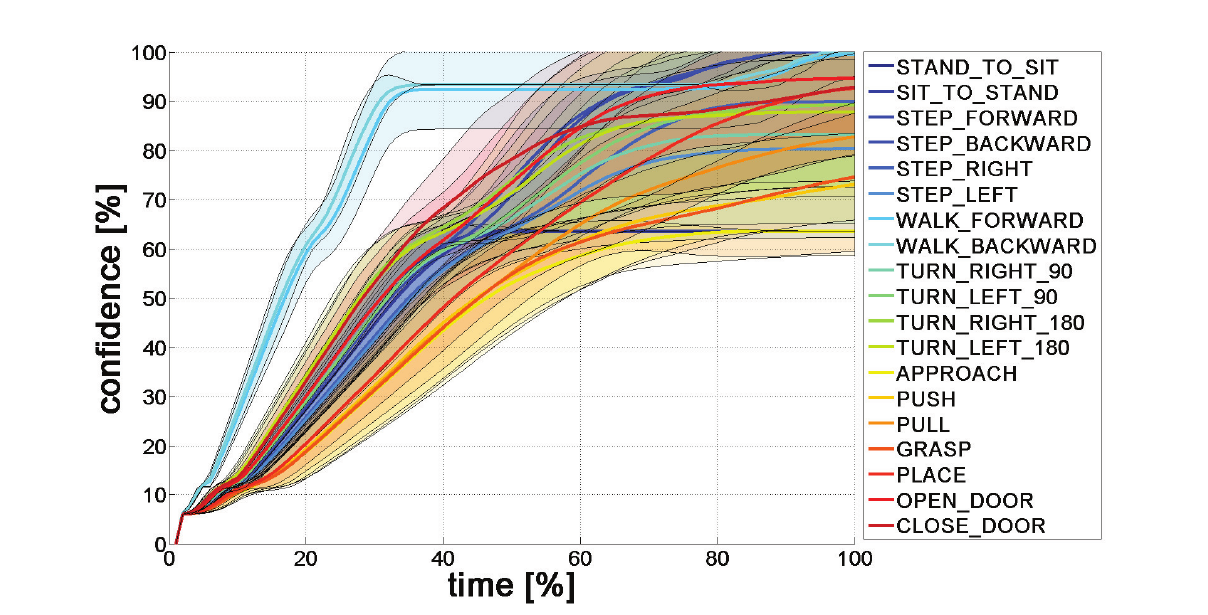
Figure 18. Comparison result of all primitive actions against an input of STEP_FORWARD action. The colored lines represent the mean confidence of the corresponding actions (see legend). The shaded areas around each mean shows the variance. Time has been normalized with respect to the length of the